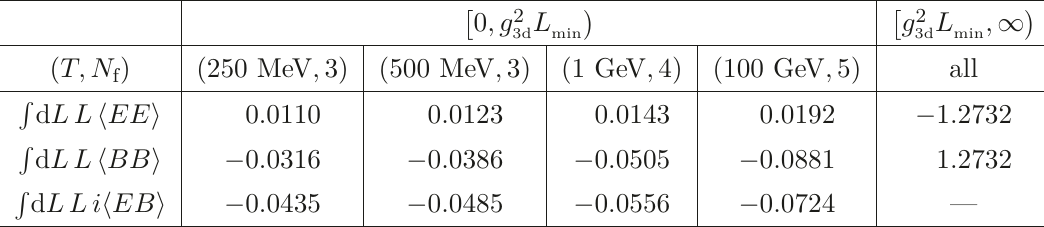
Table 3 . Counterterms according to table 2 integrated over the two different intervals with IR cutoff g 2 L . The quoted numbers are in units of g 4 3d min